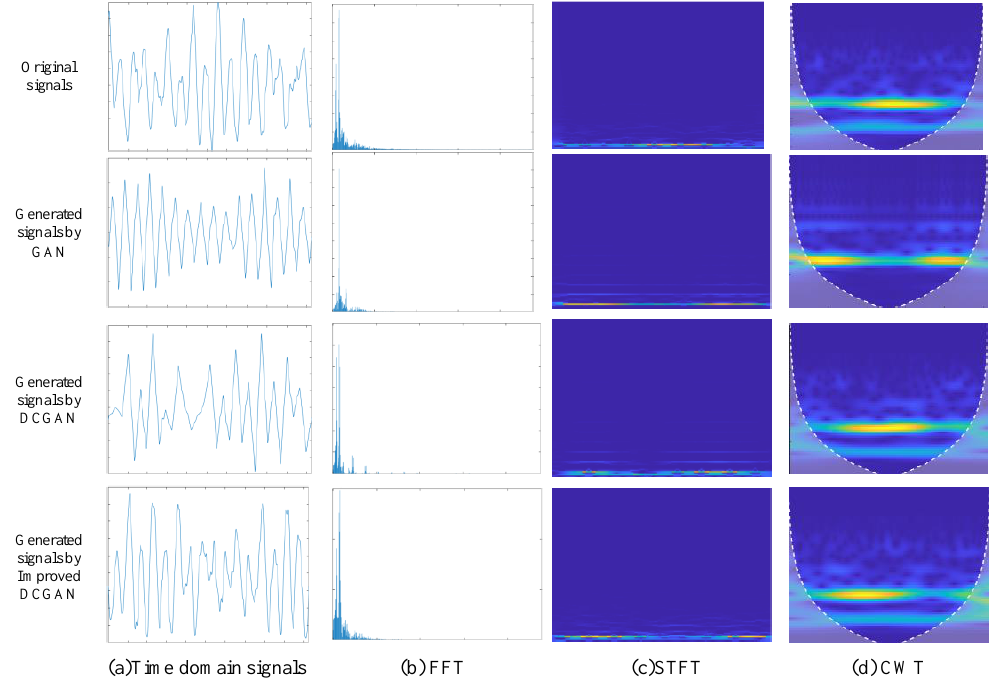
Figure 14. Signal comparison of time domain and frequency domain of the original signals and the generated signals in normal state.